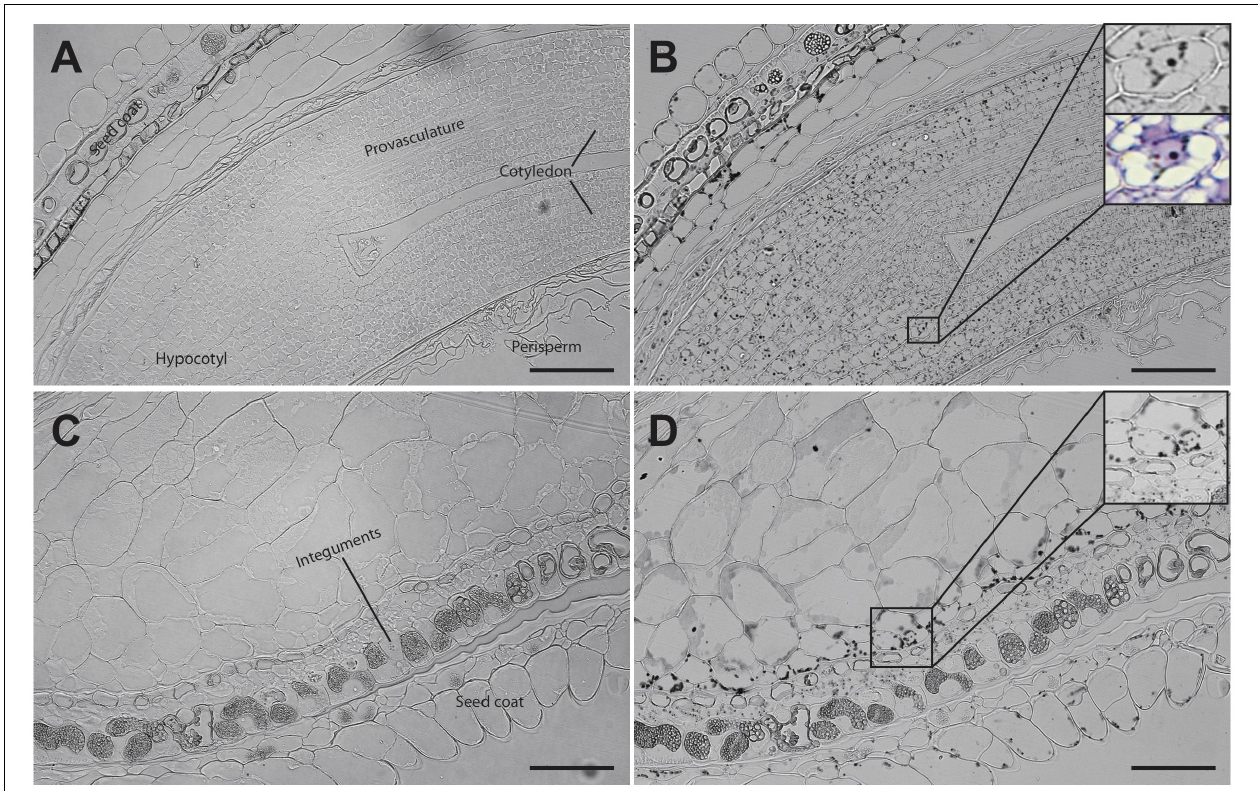
FIGURE 5 | Iron distribution in C. quinoa seeds at cotyledon stage. C. quinoa seeds at the cotyledon stage (14 days postanthesis) dissected from fruits were embedded in Technovit resin, sectioned (3 µ m) and then stained with Perls/DAB (B , D) . In B the zoom shows iron accumulation into and around the nuclei. In B and D toluidine blue was used to show different cell structures. Unstained sections were used as control (A , C) . The scale bar represents 100 µ m.